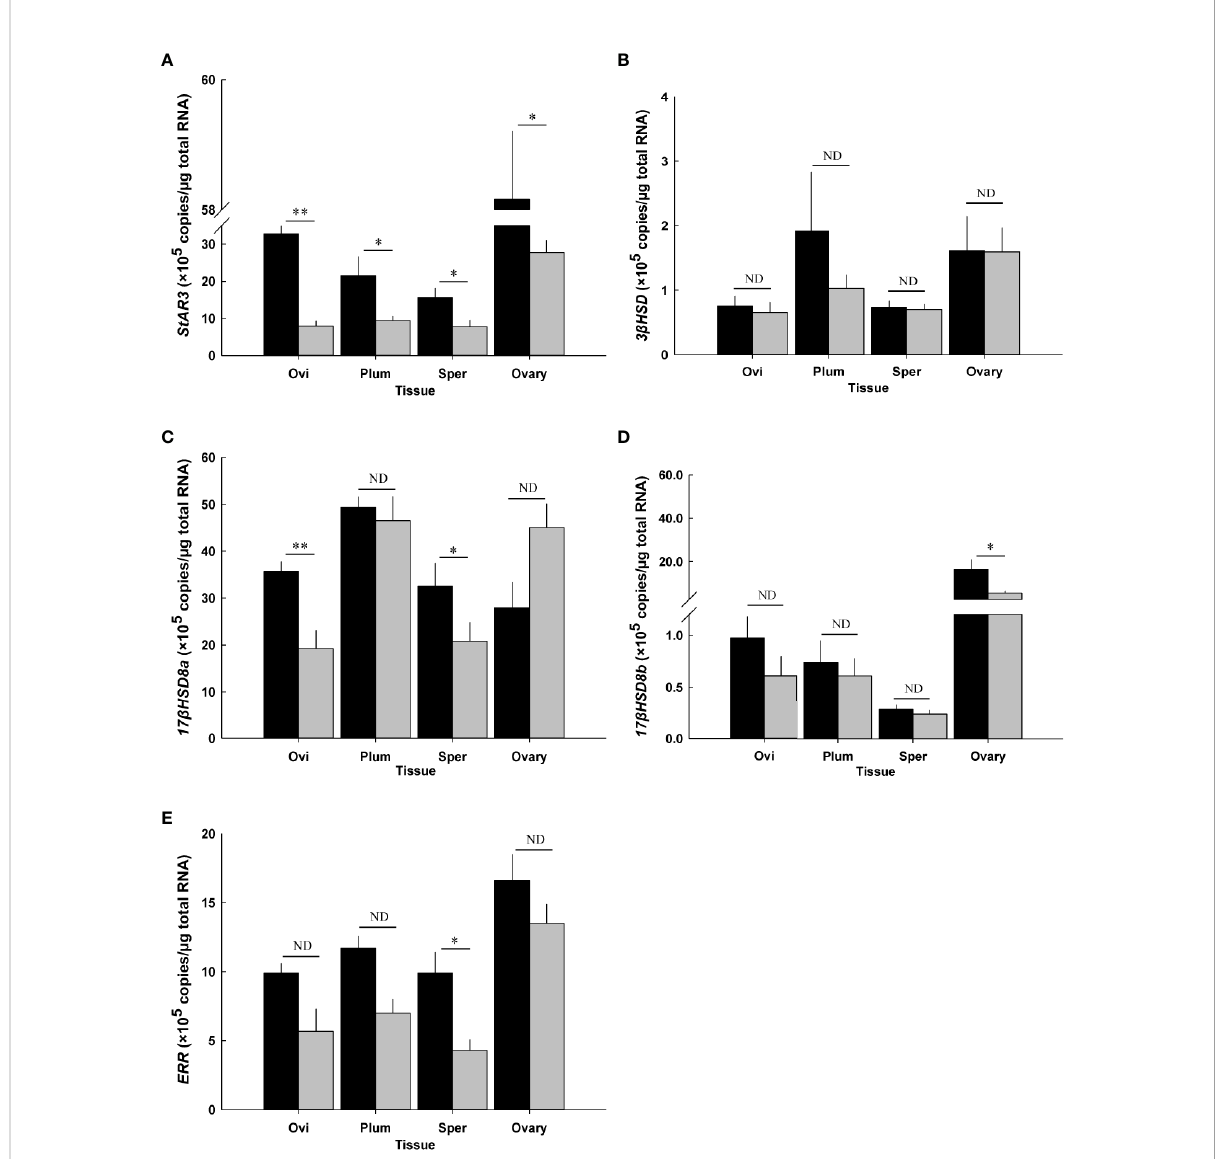
FIGURE 10 Effect of CFSH-dsRNA injection on the expression of steroidogenesis-related genes using qRT-PCR assay. (A) StAR3, (B) 3 b HSD, (C) 17 b HSD8a, (D) 17 b HSD8b, and (E) ERR. Expression levels are represented as mean ± SE ( n = 5) transcripts/ m g total RNA. The data are presented as mean ± SE ( n = 5). * p < 0.05; ** p < 0.01; nd, no difference. Ovi, ovigerous setae; Plum, plumose setae; Sper,